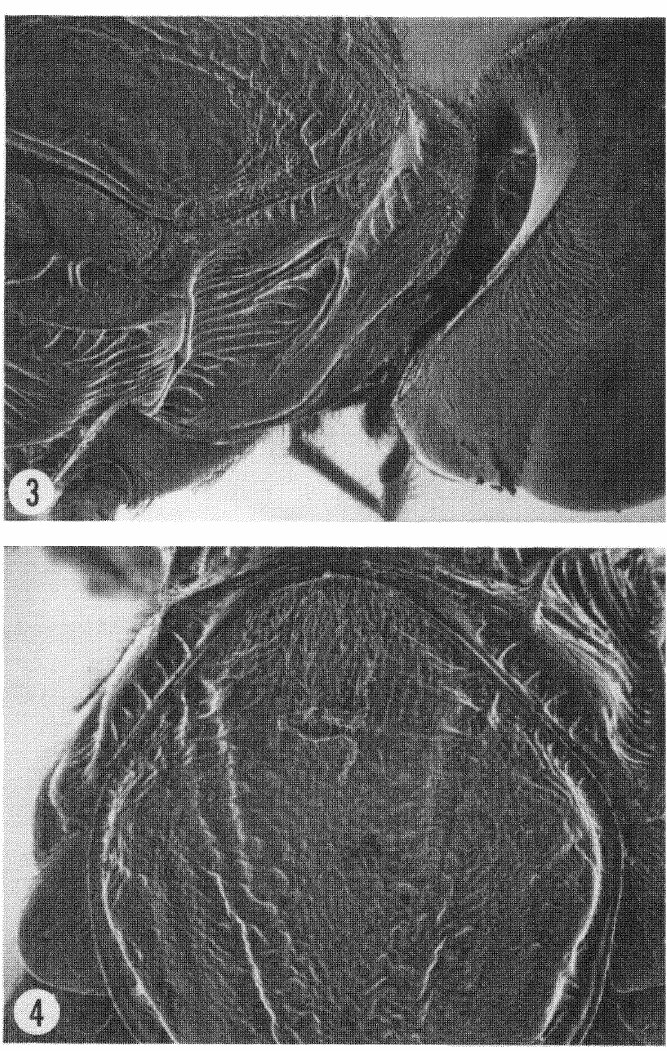
Fig. 3. Cosmiocryptus huascar, lateral part of thorax. Fig. 4. Cosmiocryptus huascar, and most of mesoscutum in dorsal